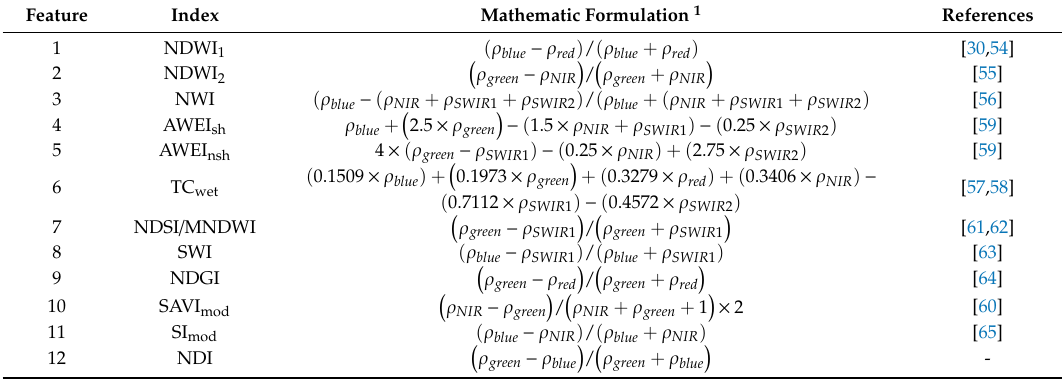
5 AWEI nsh 4 × ( ρ green − ρ SWIR 1 ) − ( 0.25 × ρ NIR ) + ( 2.75 × ρ SWIR 2